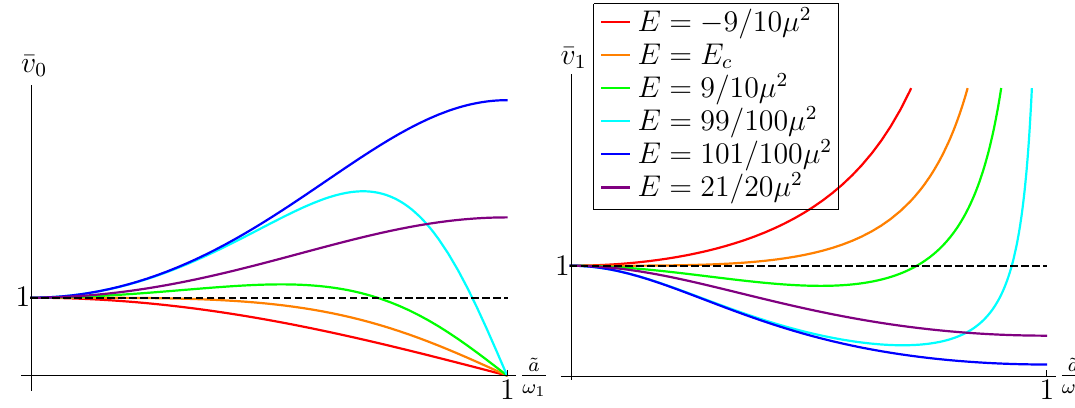
Figure 1 . The mean velocity as function of ~ a for translationally invariant seeds (left) and static seeds (right) for various values of the energy constant E